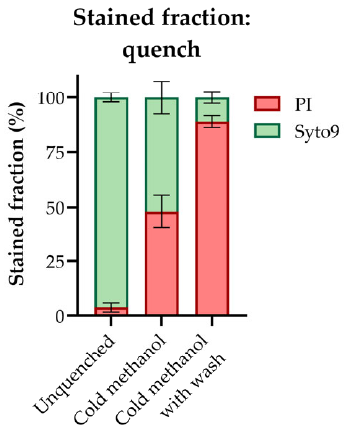
Figure 1. The fraction of propidium iodide (PI) and Syto9 stained cells in an unquenched E. coli culture and a cold methanol-quenched ( − 30 ◦ C) E. coli culture with and without subsequent washing in cold methanol ( − 30 ◦ C), as estimated by fluorescence microscopy imagining. The average ± SD of n = 5 technical replicates is presented. More than 50 cells were counted per technical replicate.